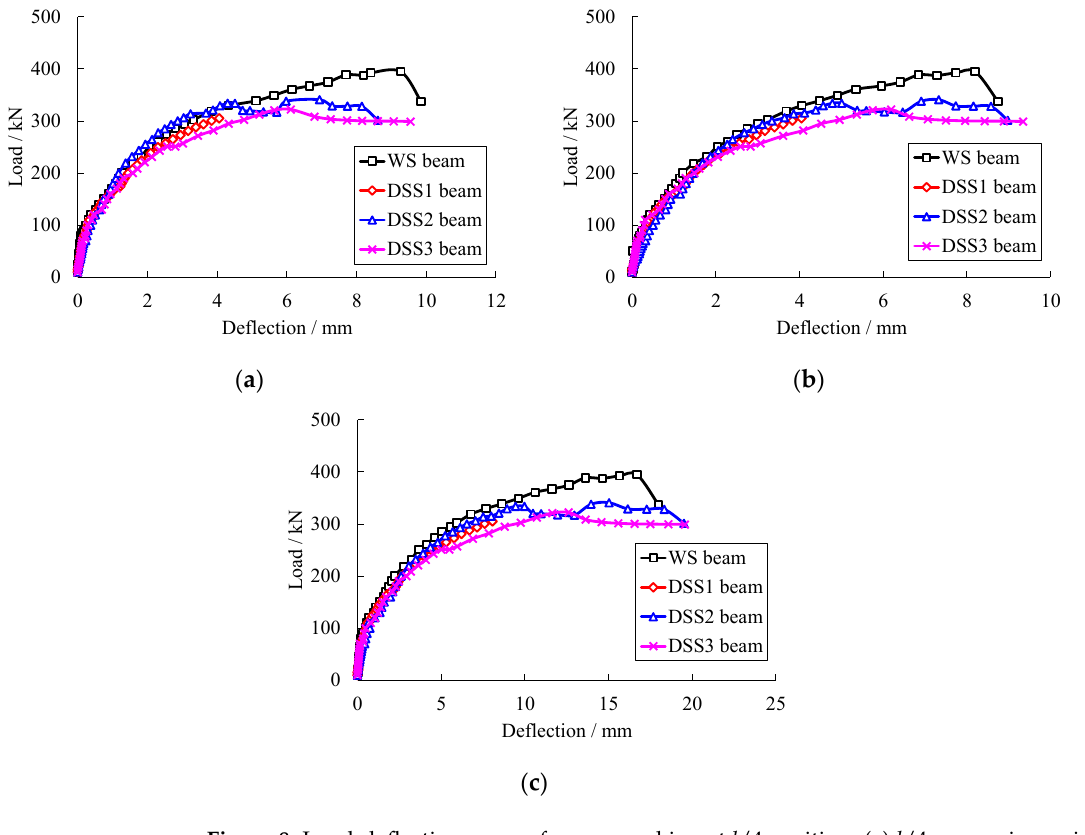
Figure 8. Load-deflection curves for pre-cracking at l /4 position. ( a ) l /4 measuring point; ( b ) 3 l /4 measuring point; ( c ) Mid-span measurement point.